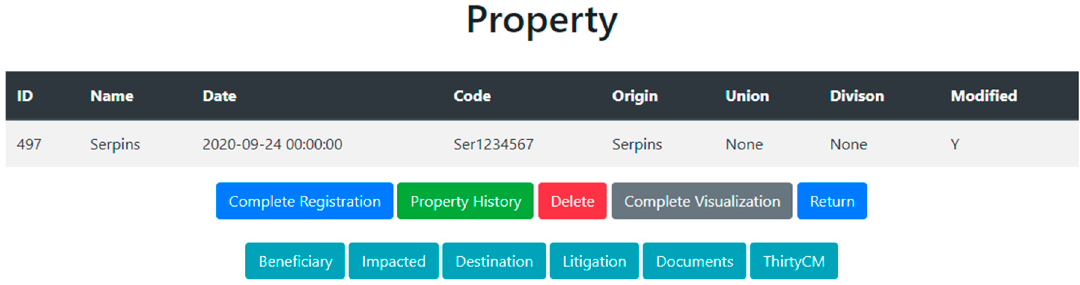
Figure 6. Property “Serpins” (ID = 497). Figure 7. Beneficiary of the property “Serpins” (ID = 497).